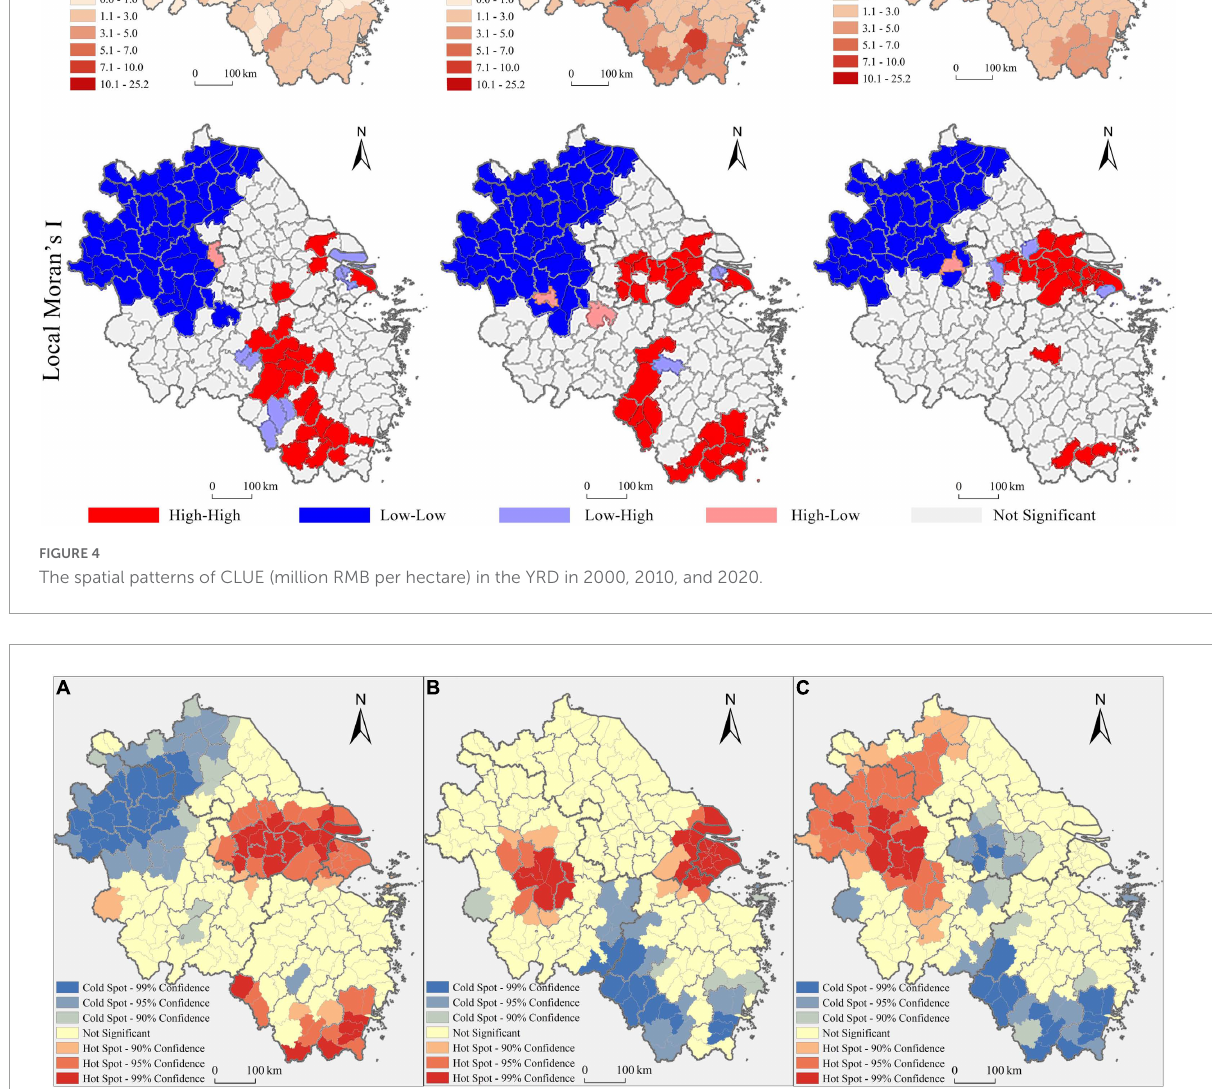
With regard to the standard deviation of CLUE by research units, a trend of continuing growth can be found in the groups of the core YRD and the central cities, while the groups of the